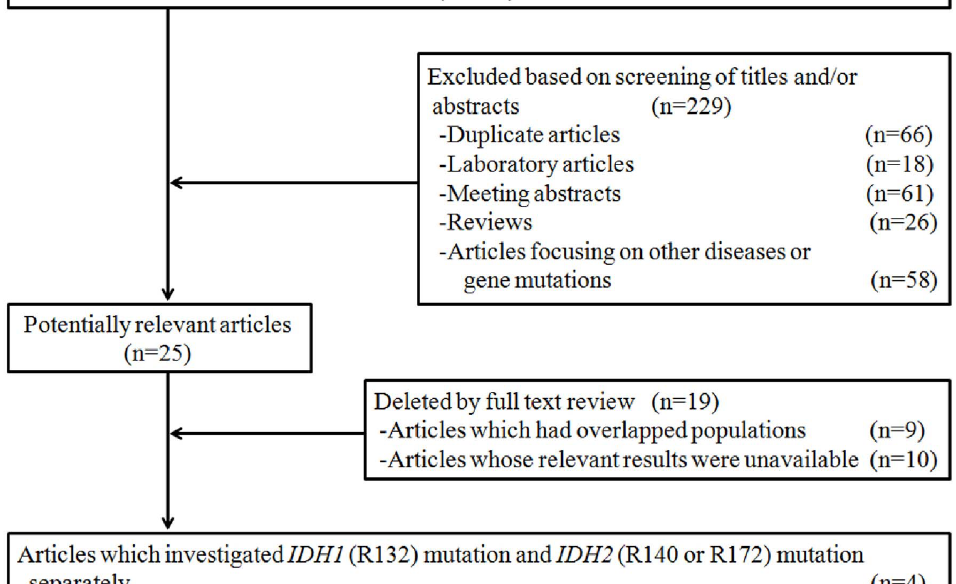
Figure 1. Flow diagram of study selection. 16 patients. IPSS risk distributions were: low risk in 7 patients (4.97%), intermediate-1 risk in 76 patients (53.90%), intermediate- 2 risk in 46 patients (32.62%) and high risk in 12 patients (8.51%).